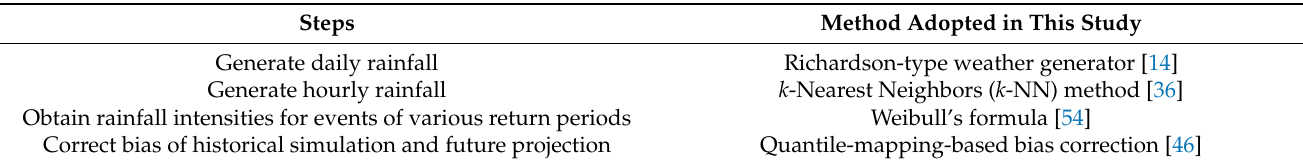
Table 2. Procedure for obtaining future rainfall